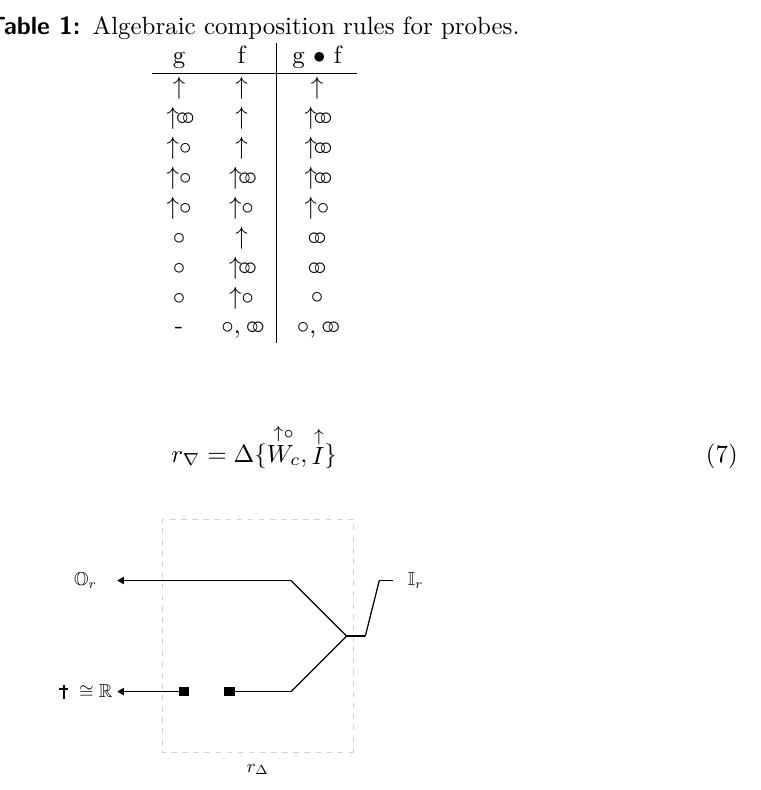
Figure 7: The vulnerability profile of a register in terms of maps over the Fourier transform of input and output